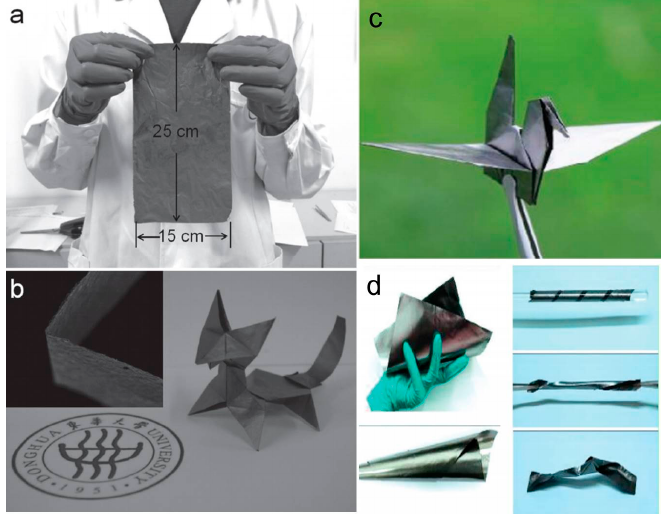
Figure 6. ( a ) Large-area and free-standing GF from direct evaporation; ( b ) sharply folded and twisted craft from the GF; ( c ) a piece of GF was folded into a crane without breakages; and ( d ) the GF in the states of bending, curling, enwinding, twisting and knotting. ( a , b ) Reprinted from [22] with permission, Copyright 2017 Wiley Online Library; ( c , d ) Reprinted from [28] with permission, Copyright 2017 Wiley Online Library.